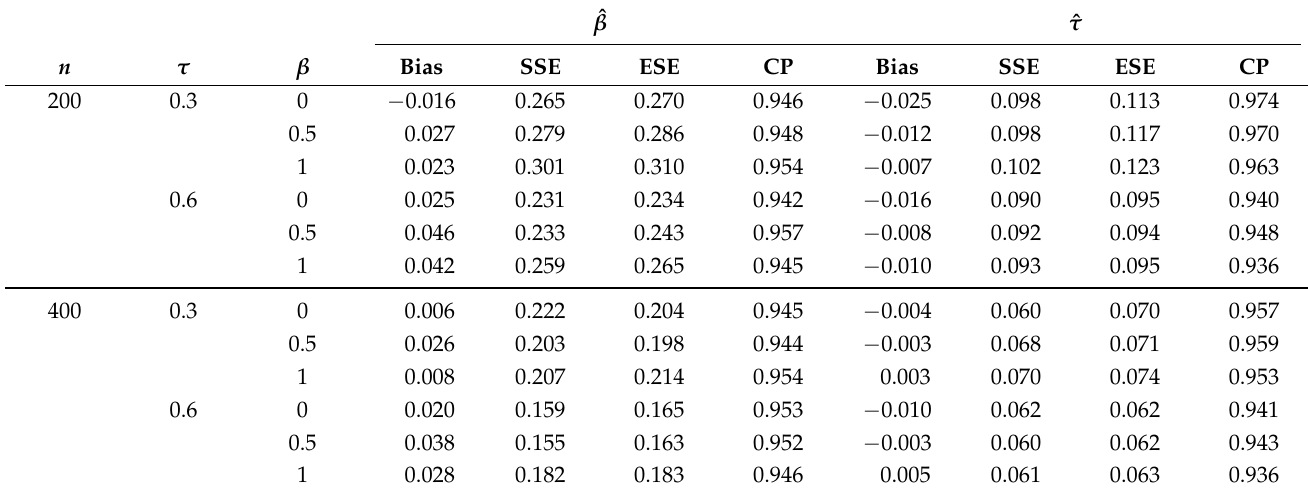
Table 4. Estimation results on β and τ with the time-dependent covariates.